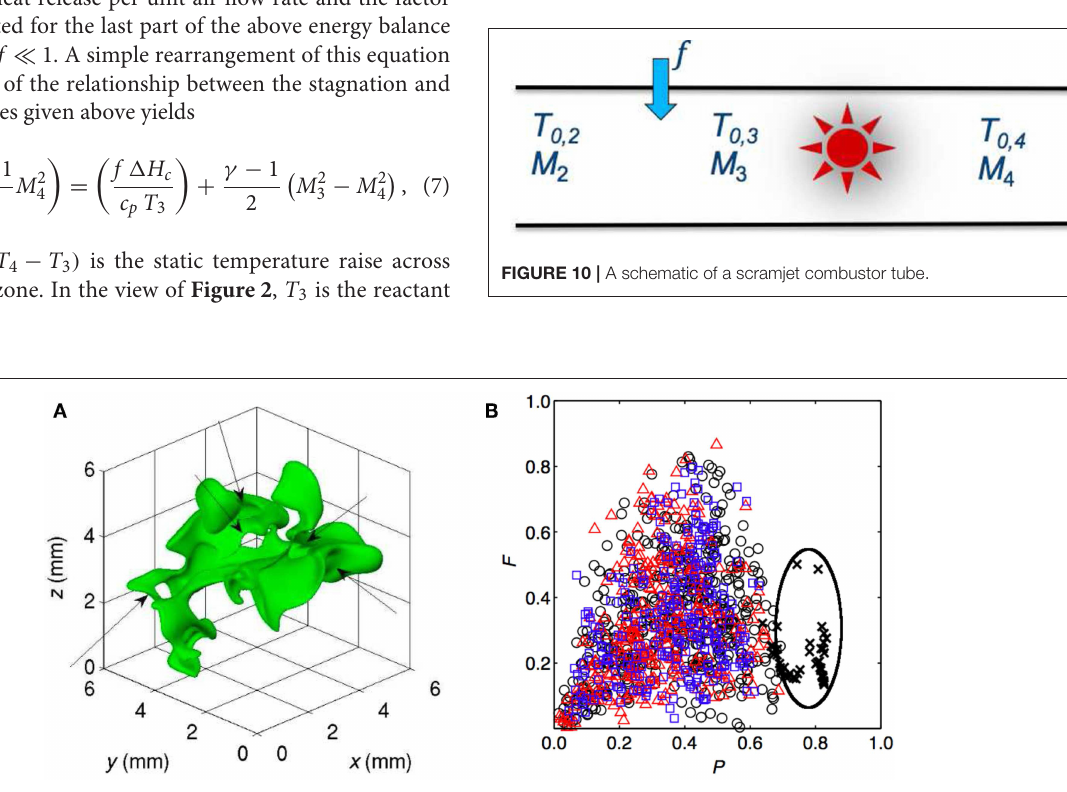
FIGURE 9 | (A) Morphology of a typical heat releasing zone in the MILD combustion case, P1. (B) Values of shape finder , P and F , in the cases P1 ◦ , P2 , P3 , and conventional premixed combustion × , adapted from Minamoto (2013) under a Creative Commons license.